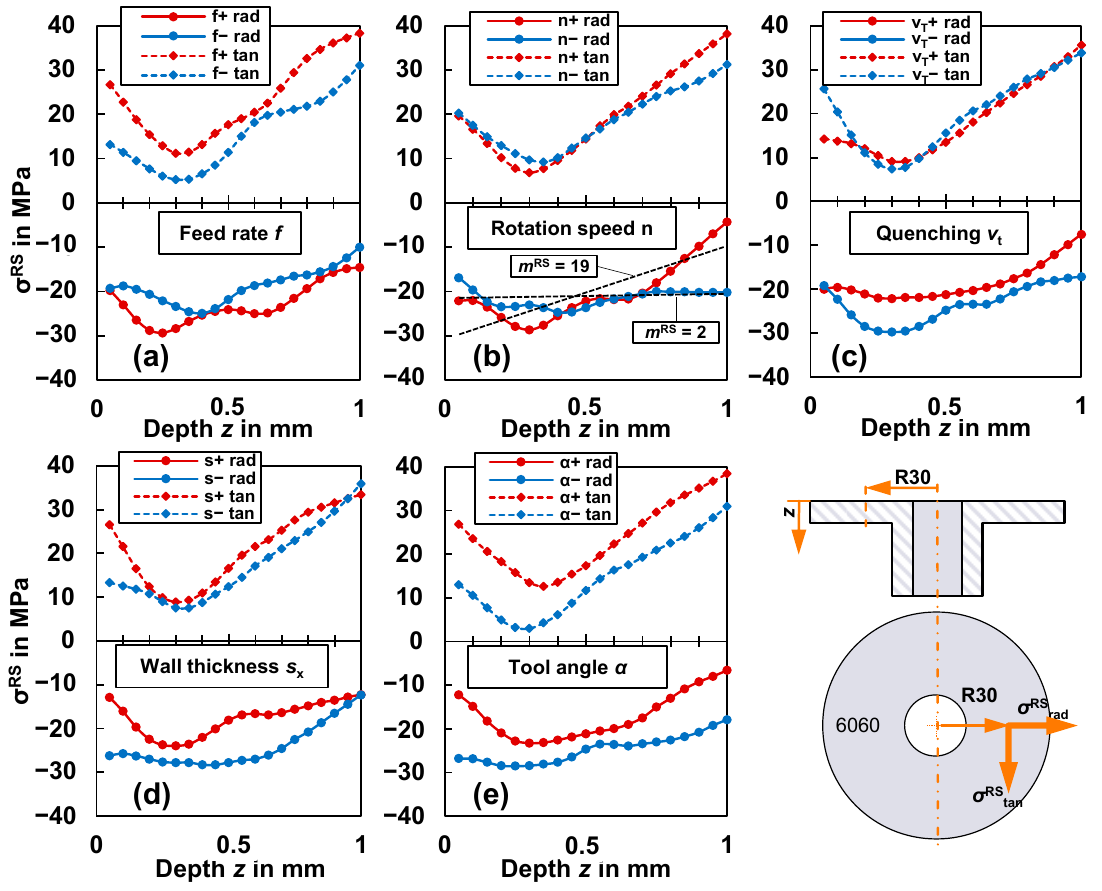
Figure 10. Residual stress depth profile in flanges formed by the friction-spinning of aluminium tubes (3.0206) in the tangential and radial direction. Effects of the process parameters determined with the design of experiments (DoE) methods: (a) feed rate f , (b) rotation speed n , (c) quenching v t , (d) wall thickness s x and (f) tool angle α .